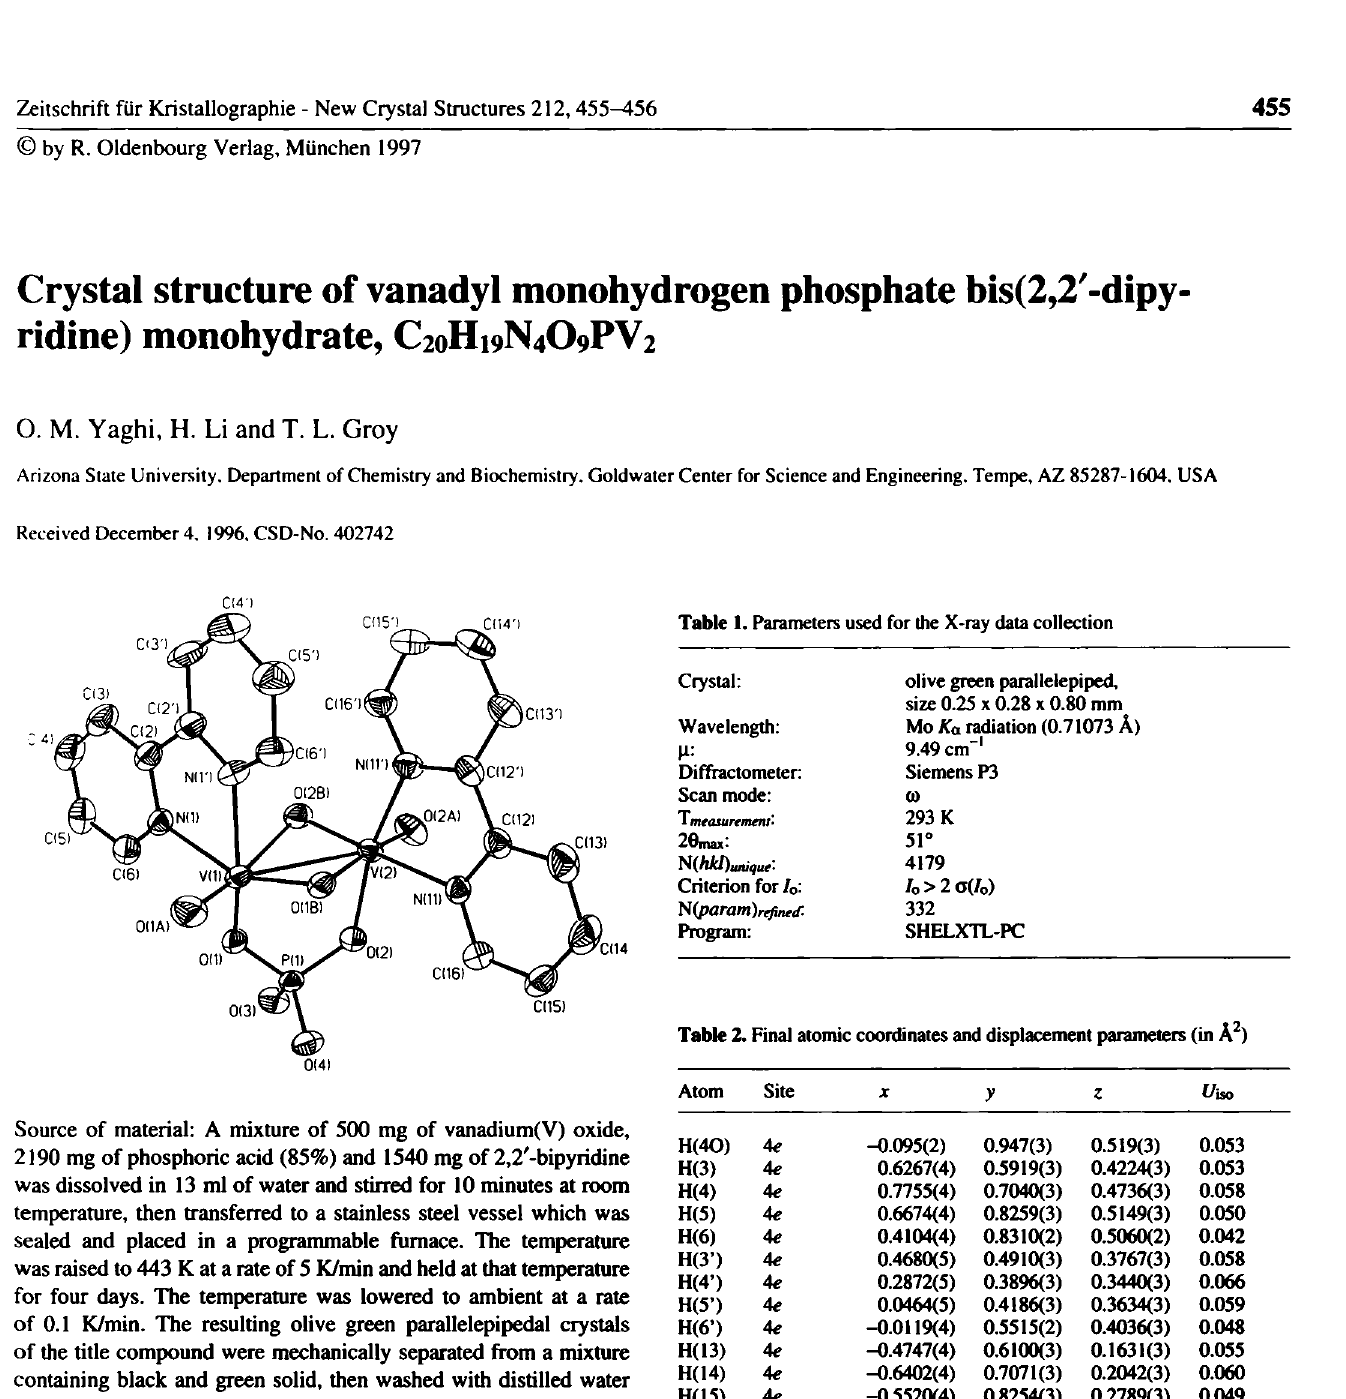
Table 2. Final atomic coordinates and displacement parameters (in Â 2